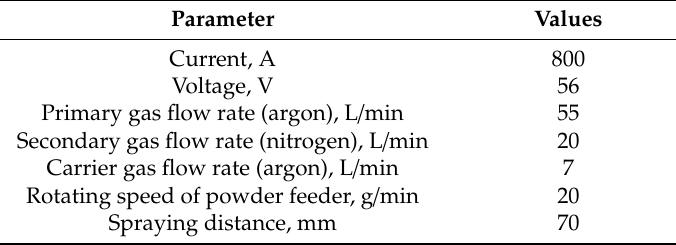
Table 1. Principal parameters used during plasma spraying.